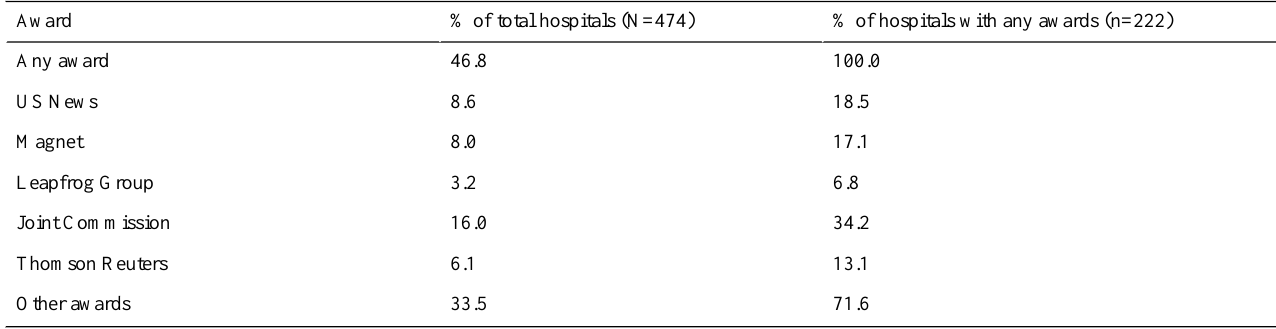
Table 5. Awards listed on hospital